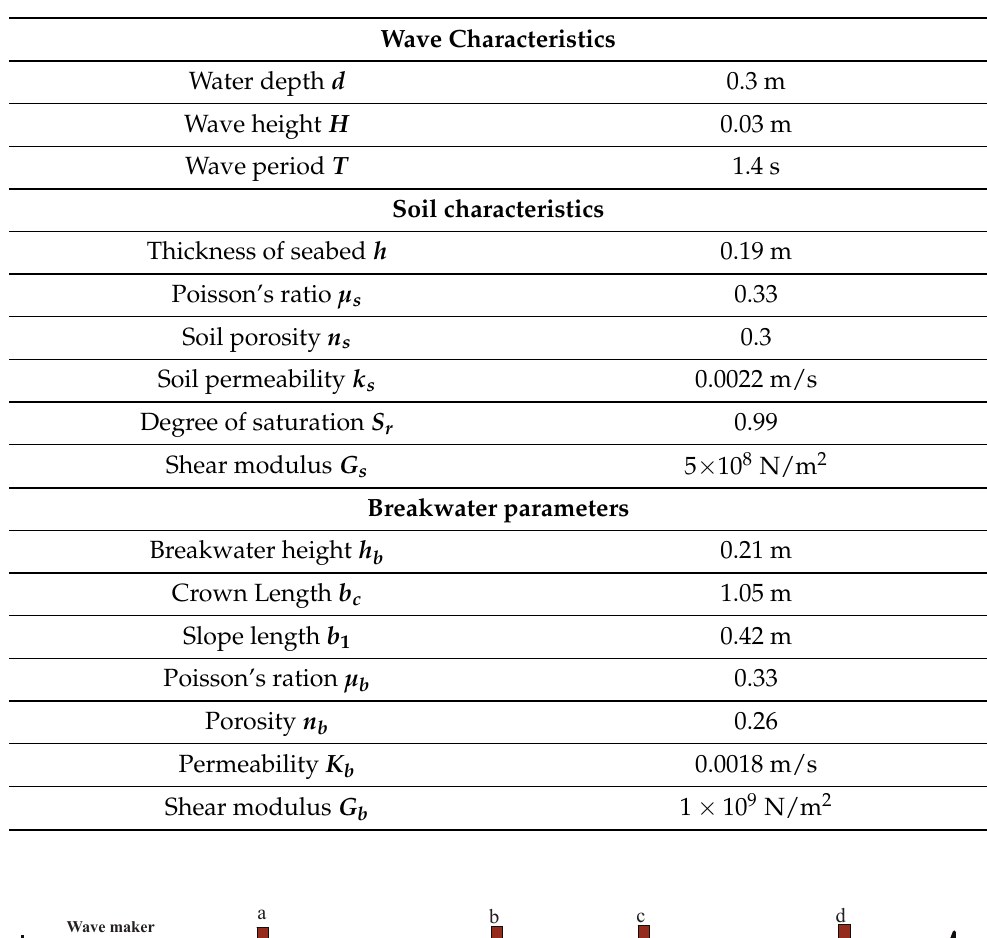
Table 1. Input data for model validation with Reference [48].